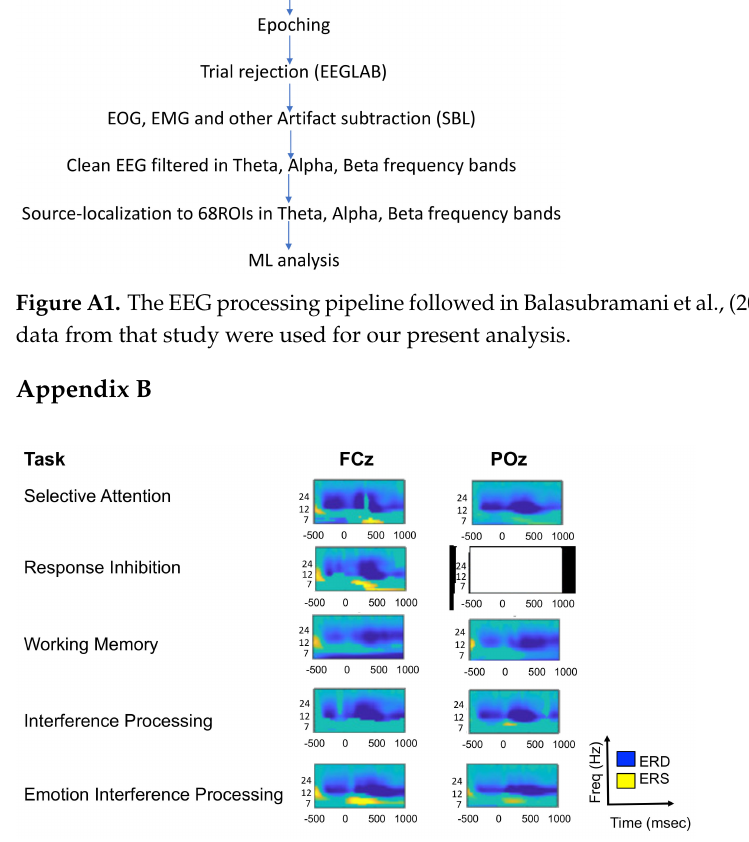
Figure A2. The figure shows the stimulus-locked ERSP results from Balasubramani et al., (2021). The source − localized data from that study were used for our present